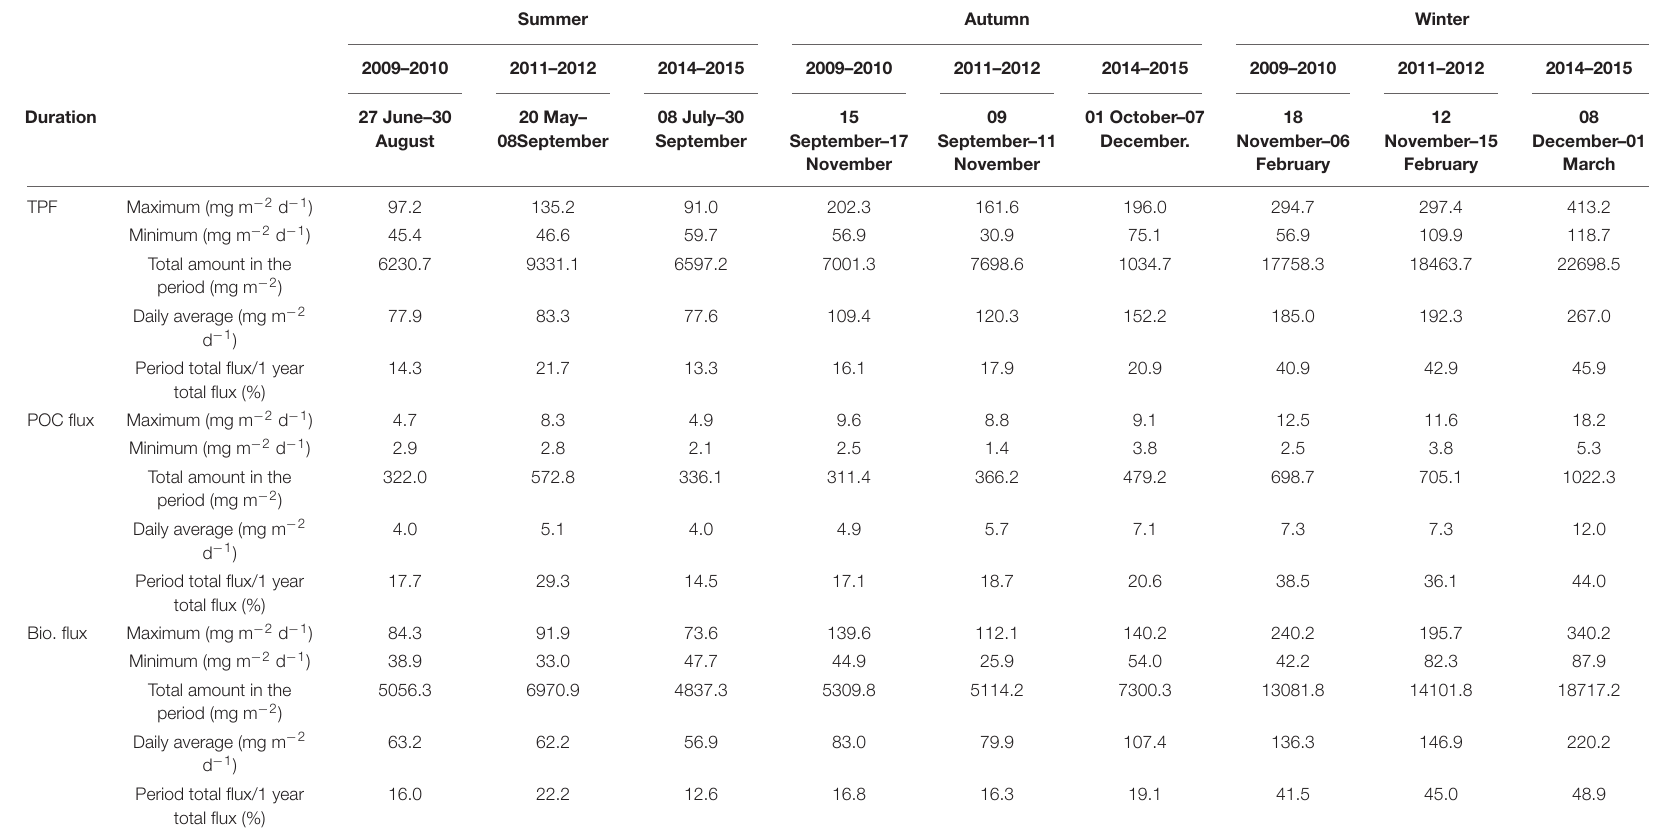
TABLE 2 | Comparison of Total particulate fluxes (TPF), POC fluxes and biogenic matter (Bio., sum of organic matter, CaCO 3 and opal fluxes) fluxes calculated for different season in 2014–2015, 2009–2010, 2011–2012 (data from Ran et al., 2015; Priyadarshani et al.,